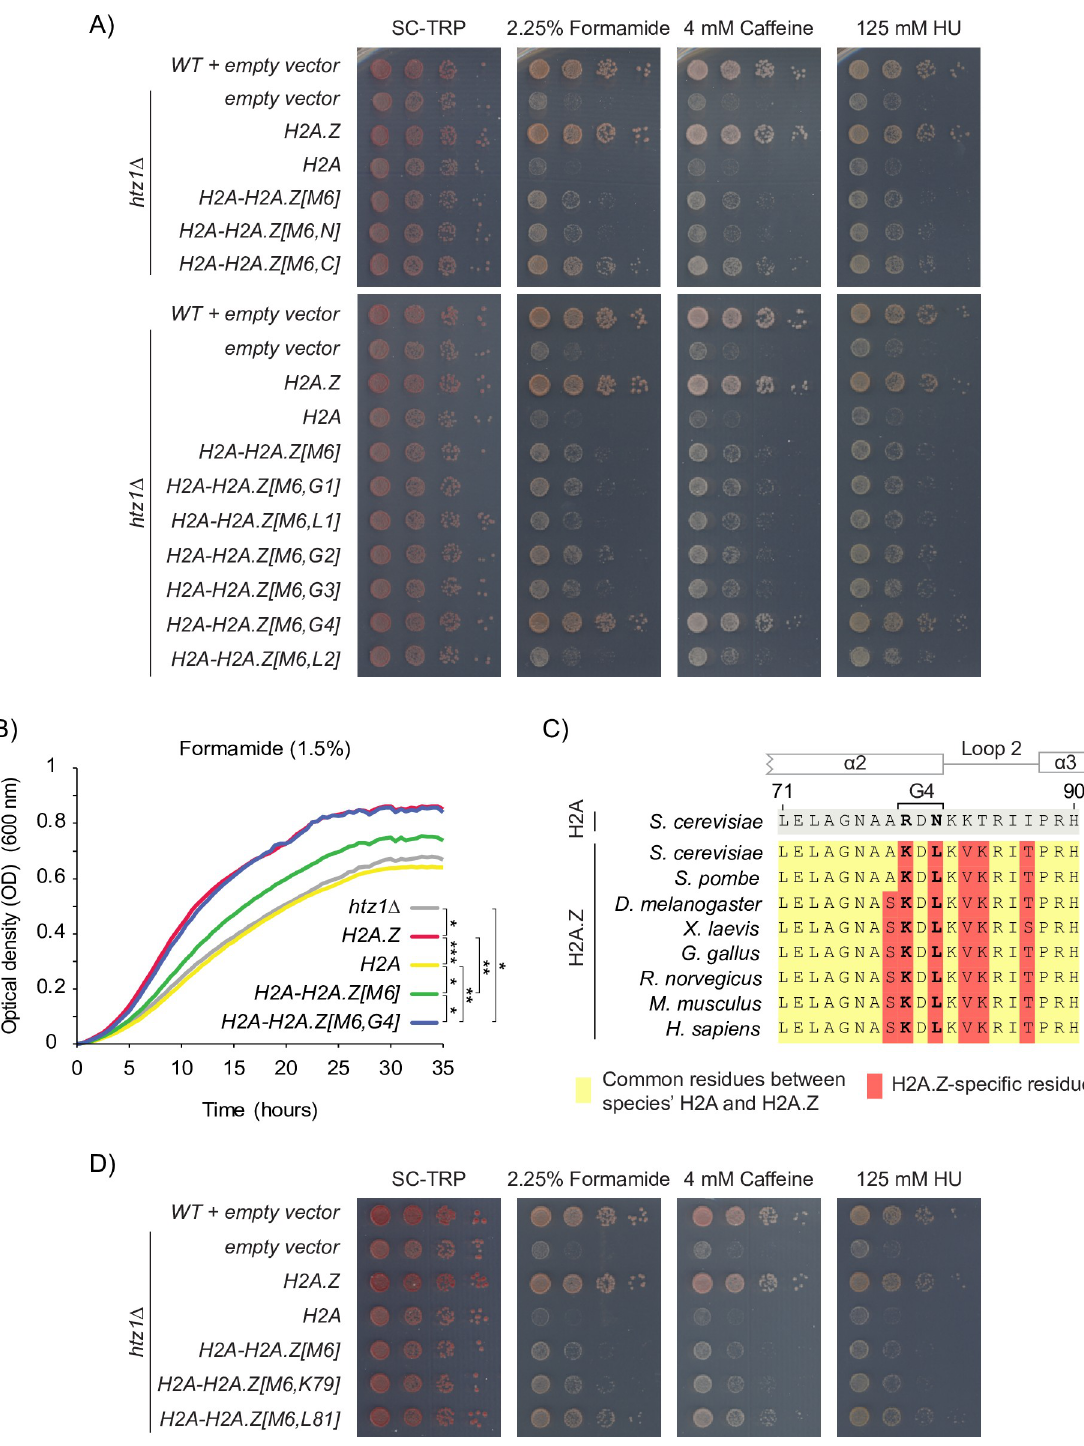
PLOS Genetics | https://doi.org/10.1371/journal.pgen.1009950 December 6, 2021 8 /